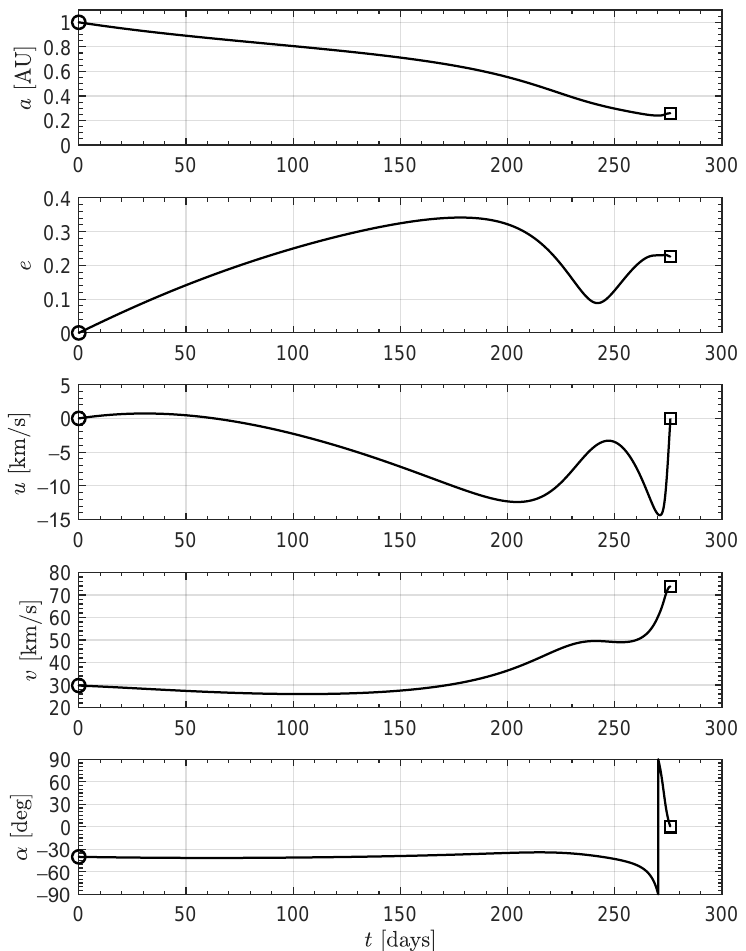
Figure 11. Osculating parameters of the transfer orbit, spacecraft velocity components and optimal steering law to reach a distance of 0.2au with zero radial velocity (case